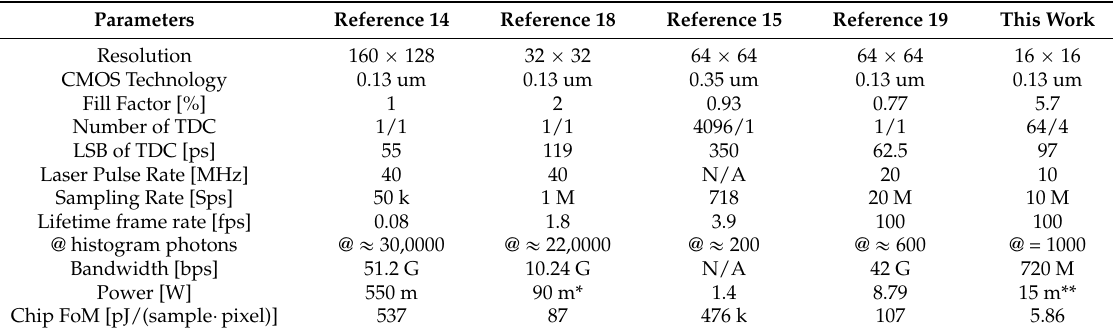
Table 3. Comparisons of different